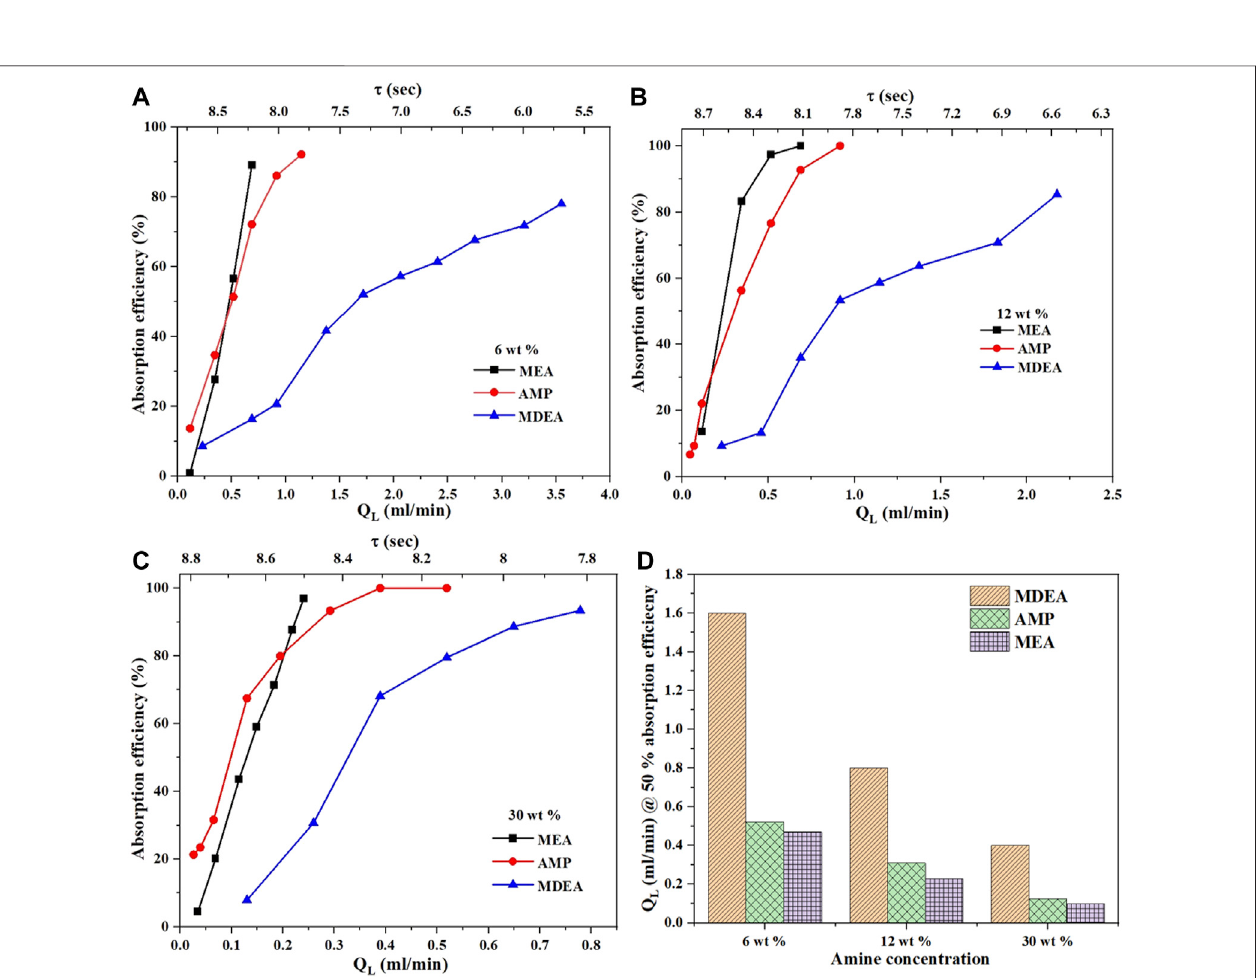
FIGURE4| CO 2 absorptionef fi ciencyinthreedifferentaminesolutionsofMEA,AMP,andMDEAat (A) 6 wt%, (B) 12 wt%,and (C) 30 wt%atCO 2 fl owof6 ml/min and reaction temperature of 30 ° C. The bar plot (D) compares the amine solutions liquid fl ow rates of the three solutions needed to achieve 50% of absorption ef fi ciency at 30 °